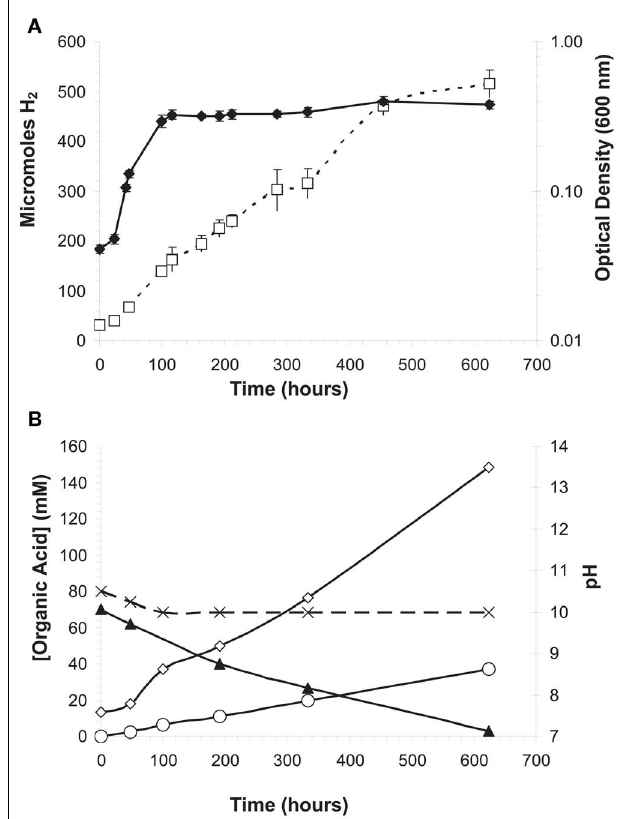
FIGURE 3 | Quantification of growth and metabolic by-products over time in H. hydrogenoformans growing on cellobiose under non-agitating conditions at 30˚C and pH 11 with 7% (v/v) NaCl. (A) Logarithmic growth ( (cid:2) ) occurred for the first 125h of cultivation at which point the cells entered stationary phase, but H 2 ( (cid:3) ) production continued beyond 600h as did (B) acetate ( ♦ ) and formate (O) production until cellobiose ( (cid:5) ) was exhausted. (B) The pH (X) of the culture initially decreased from 10.5 but never fell below 10.0.